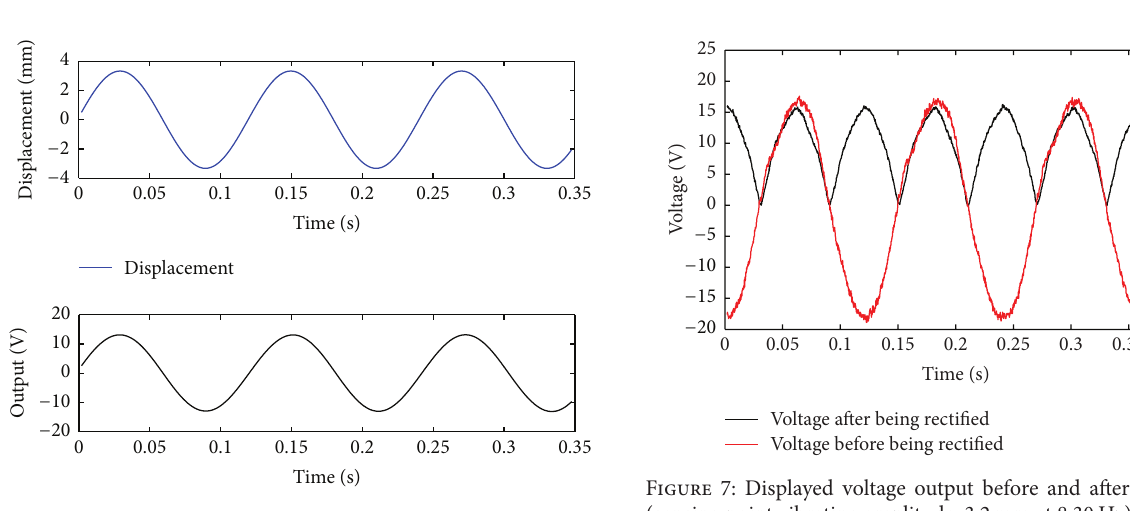
Figure 5: Electromechanical properties of EH structure: (a) the relationship between sensing point displacement of structure and the average strain of the EH region, (b) the relationship between the average strain of the EH region and the charge output.